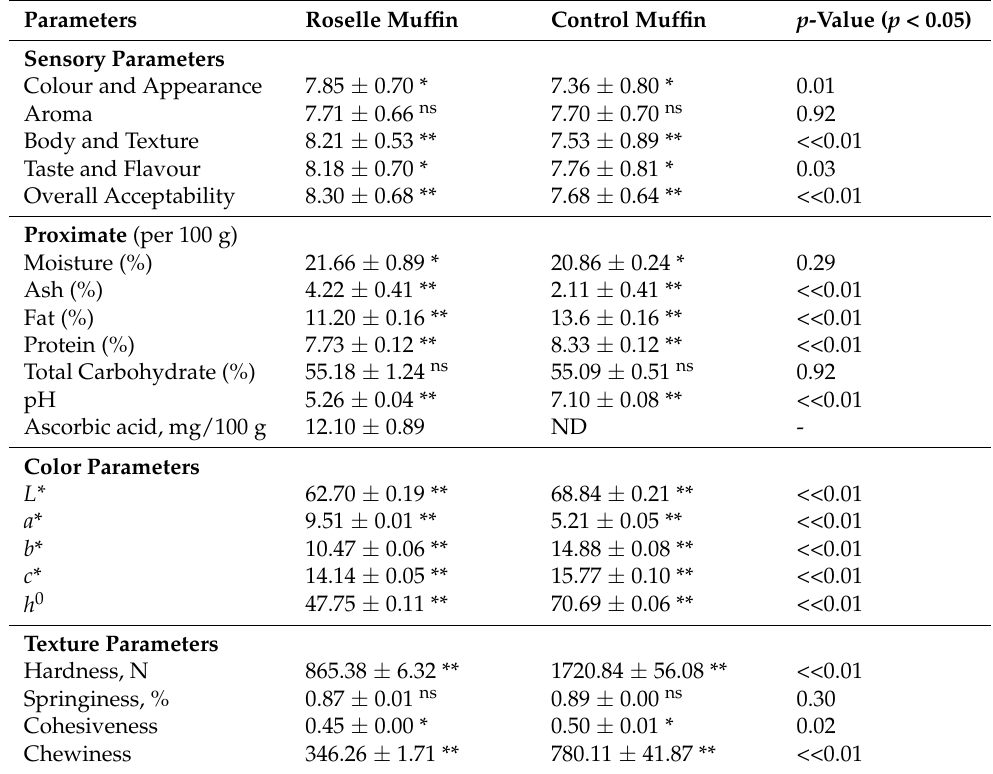
Table 5. Sensory and physicochemical characteristics of